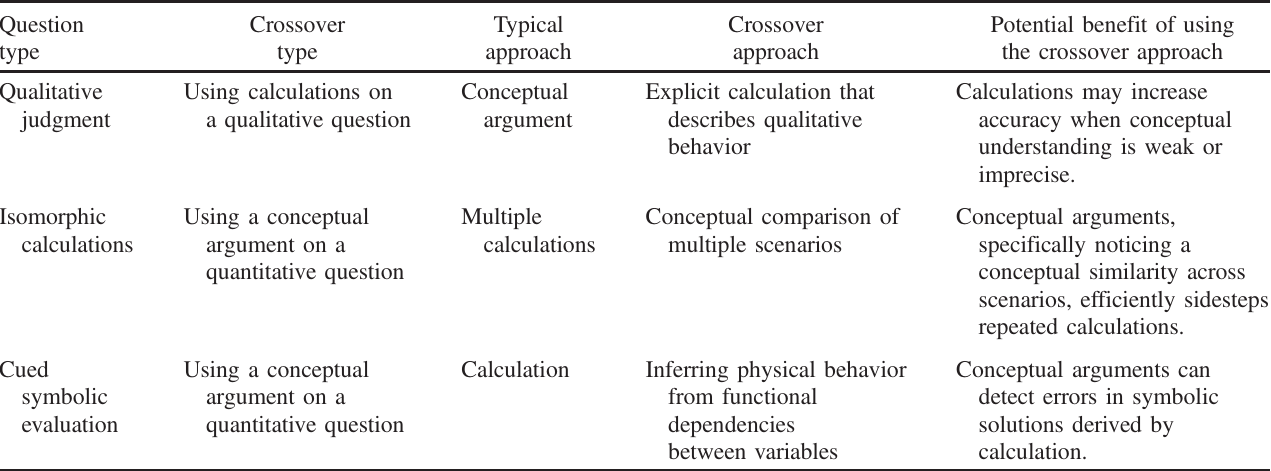
TABLE I. The three types of questions for assessing calculation-concept crossover used in this study, the type of crossover approach probed by each one, and the potential benefits of these crossover approaches.